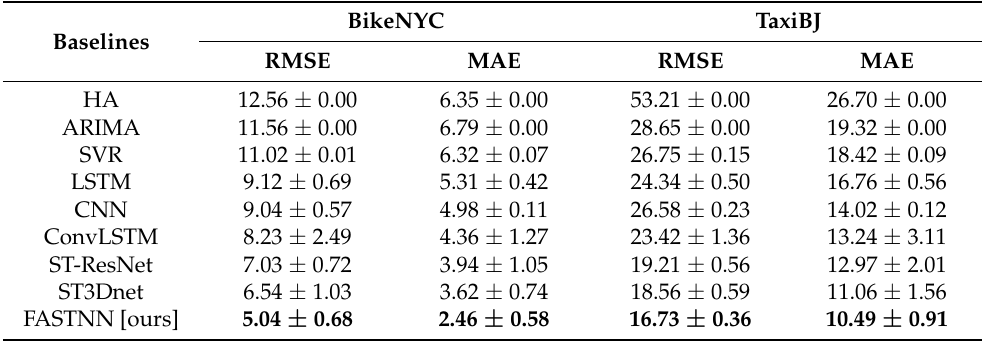
Table 3. Comparison of performance under different baselines. (Note: Bold represents the best